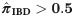
Logit-transformed proportions of highly related 2001–2014 barcode parasite sample pairs with respect to inter-clinic distance.Annotations refer to site comparisons using abbreviated clinic names (MLA for Maela, 212 parasite samples; WPA for Wang Pha, 457 parasite samples; MKK for Mae Kon Ken, 116 parasite samples; and MKT for Mawker Thai, 388 parasite samples). All parasite samples were single-infection. For inter-clinic pair A and B say, the proportion was based on nA × nB parasite sample pairs, where n denotes the number of parasite samples per clinic. Error bars represent 95% confidence intervals based on bootstrapping over highly related parasite sample pair labels (equal to 1 if π^IBD>0.5 and 0 otherwise), and are therefore zero where there are no π^IBD>0.5.